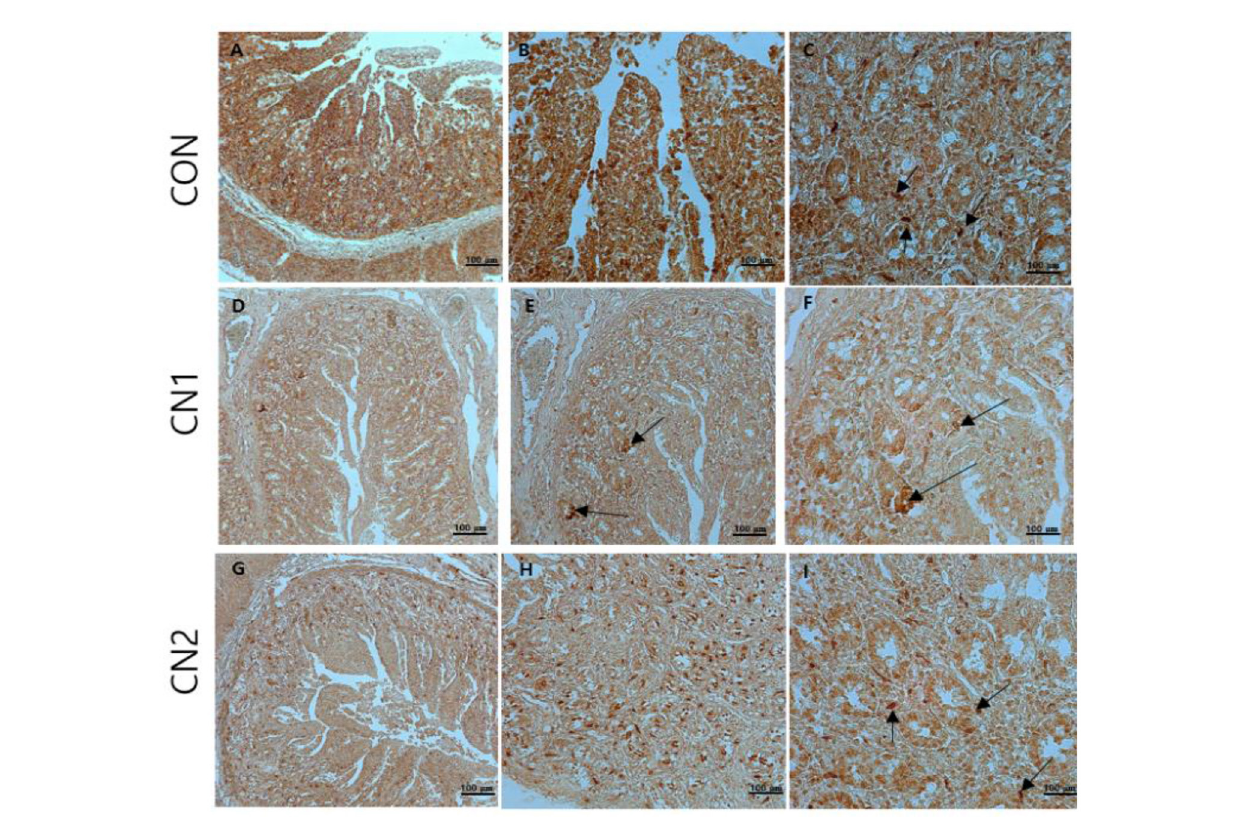
FIGURE2 The immunohistochemical slides for the expressions of tumor necrosis factor-alpha (TNF- α ) collected from the jejunal sections of small intestine ( n = 6) in finishing pigs fed (A–C) the control (CON) diet wihout curcumin nanospheres (CN); (D–F) the control diet supplemented with CN at 1.0 ml/kg diet (CN1); (G–I) the control diet supplemented with CN at 2.0 ml/kg diet (CN1); The arrow heads represents the intensity of expressions of TNF- α cytokine. The 3,3’-diaminobenzidine (DAB) is used as the substrate for tissue sections staining for viewing using bars 100 µ m at different